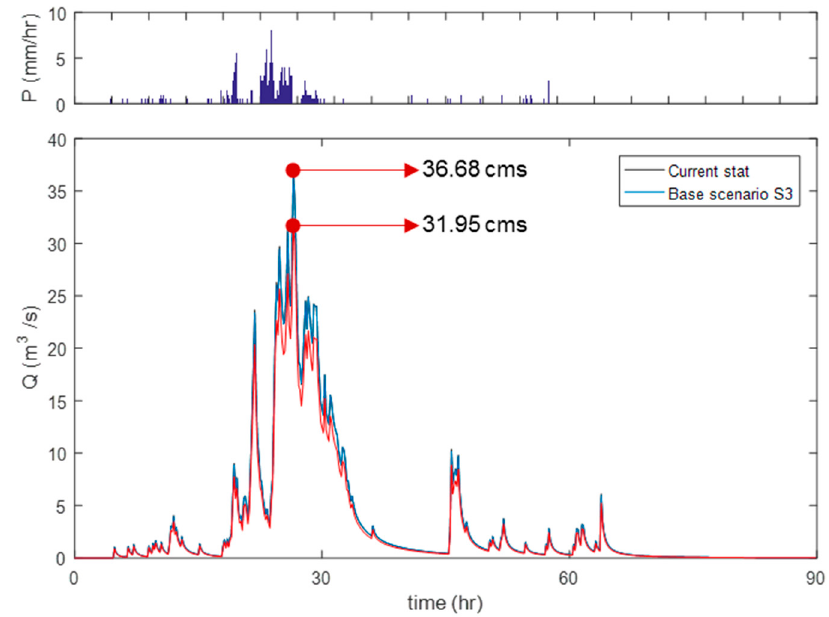
Figure 10. Resulting hydrograph for the application of Scenario 3 to the entire catchment with peak flow reduction of 12 % for the storm event on 12 July 2013.